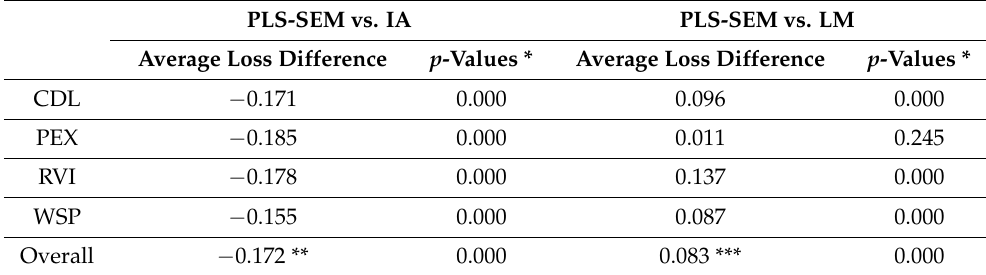
Table 6. Cross-validated predictive ability test result.